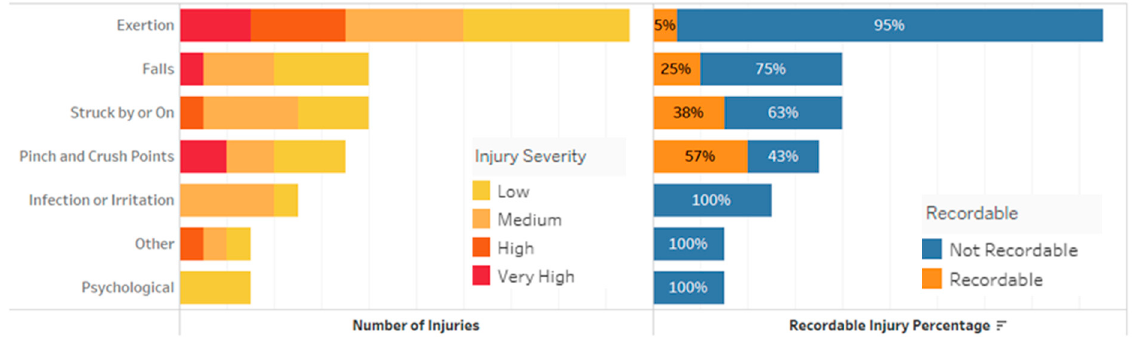
Figure 8. Volume of injuries by mechanism (coloured by insurance claim severity) beside recordable classification. Table 6. Injuries by body part, severity, and disposition.